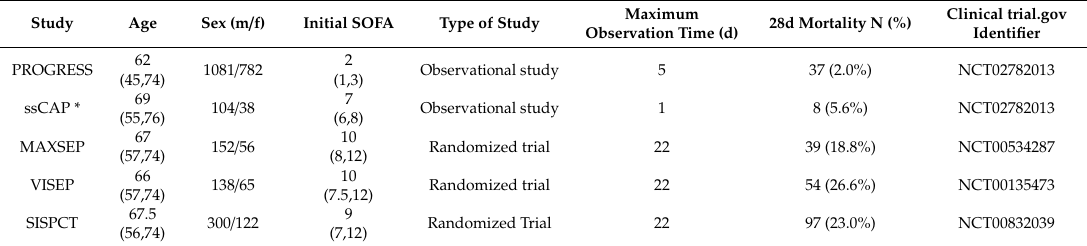
Table 1. Study Characteristics. Age and initial Sequential Organ Failure Assessment (SOFA) were reported as medians and interquartile ranges. * Subcohort of PROGRESS patients without study visits.